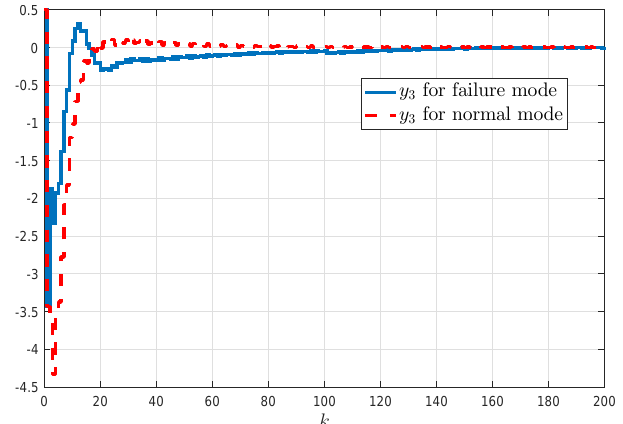
Figure 4. The response of system output variable y 3